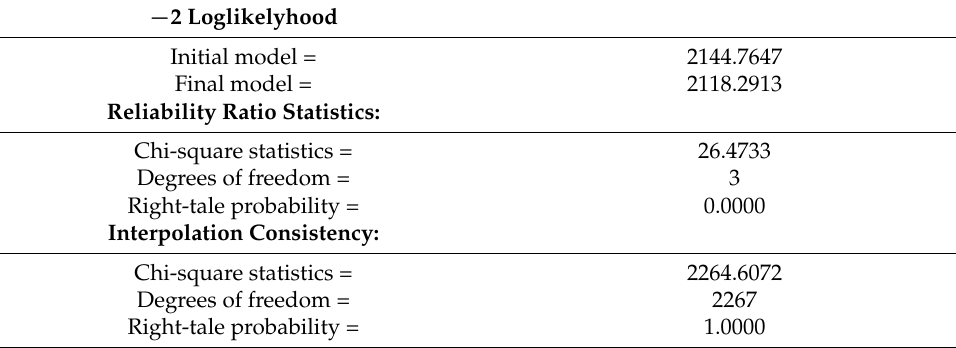
Table 4. Statistical significance of the model.